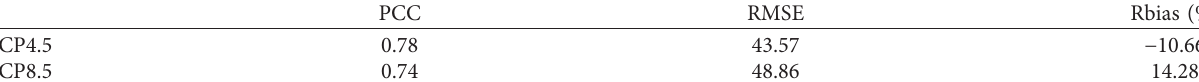
Table 12: The validation results of projected precipitation in 2006–2018.